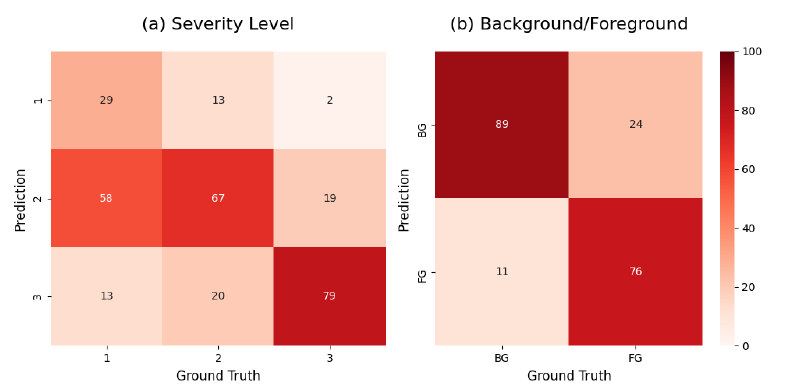
Figure 8. Confusion matrices for the defect type segmentation network (validation set). The first chart shows the confusion matrix for the foreground pixels. Most of the defect classes (A to P) show no or very low confusion with other classes. However, it is clear that for some classes, e.g., class E or P, the segmentation can still improve. This is mainly due to the fact that these classes are less represented in the dataset or that these are more difficult to detect. The second matrix shows the background/foreground confusion matrix.